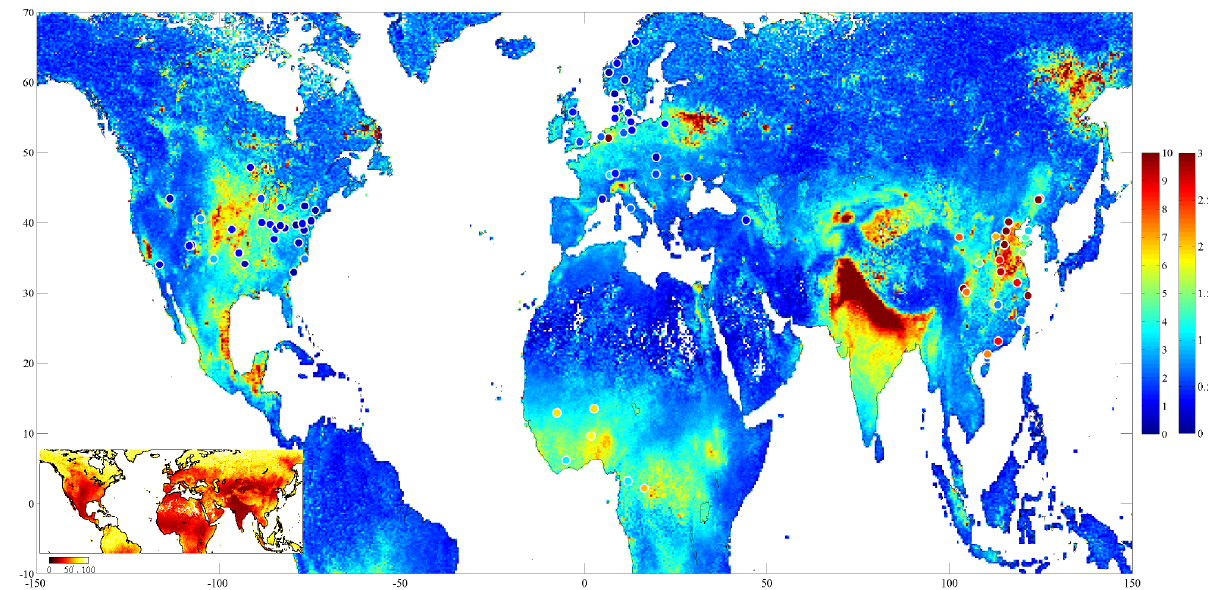
Figure 2. Yearly averaged surface concentrations (µgm − 3 , left vertical color bar) from IDAF, AMoN, EMEP and NNDMN data sets plotted on top of the NH 3 IASI satellite column ( × 10 16 moleccm − 2 , right vertical color bar) distribution for 2011 gridded at 0.25 ◦ lat × 0.5 ◦ long. Columns and relative error (%, bottom left inset) have been calculated as a weighted mean of all IASI measurements within a cell, following equations described in Van Damme et al. (2014a) (columns with an associated relative above 100% have been filtered).